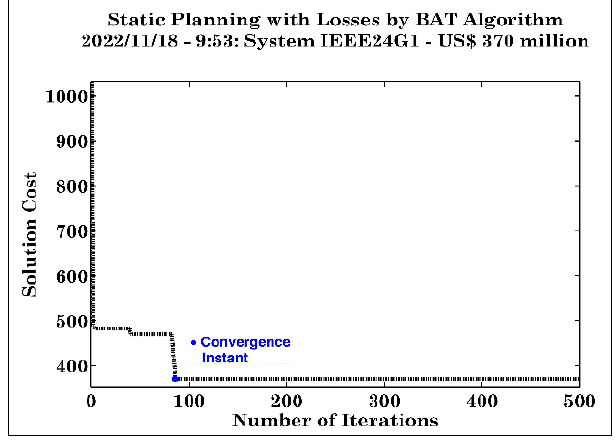
Figure 9: Case WOR - IEEE-24/41 test system. Cost convergence curve. Source: BATp optimizer, (2022).